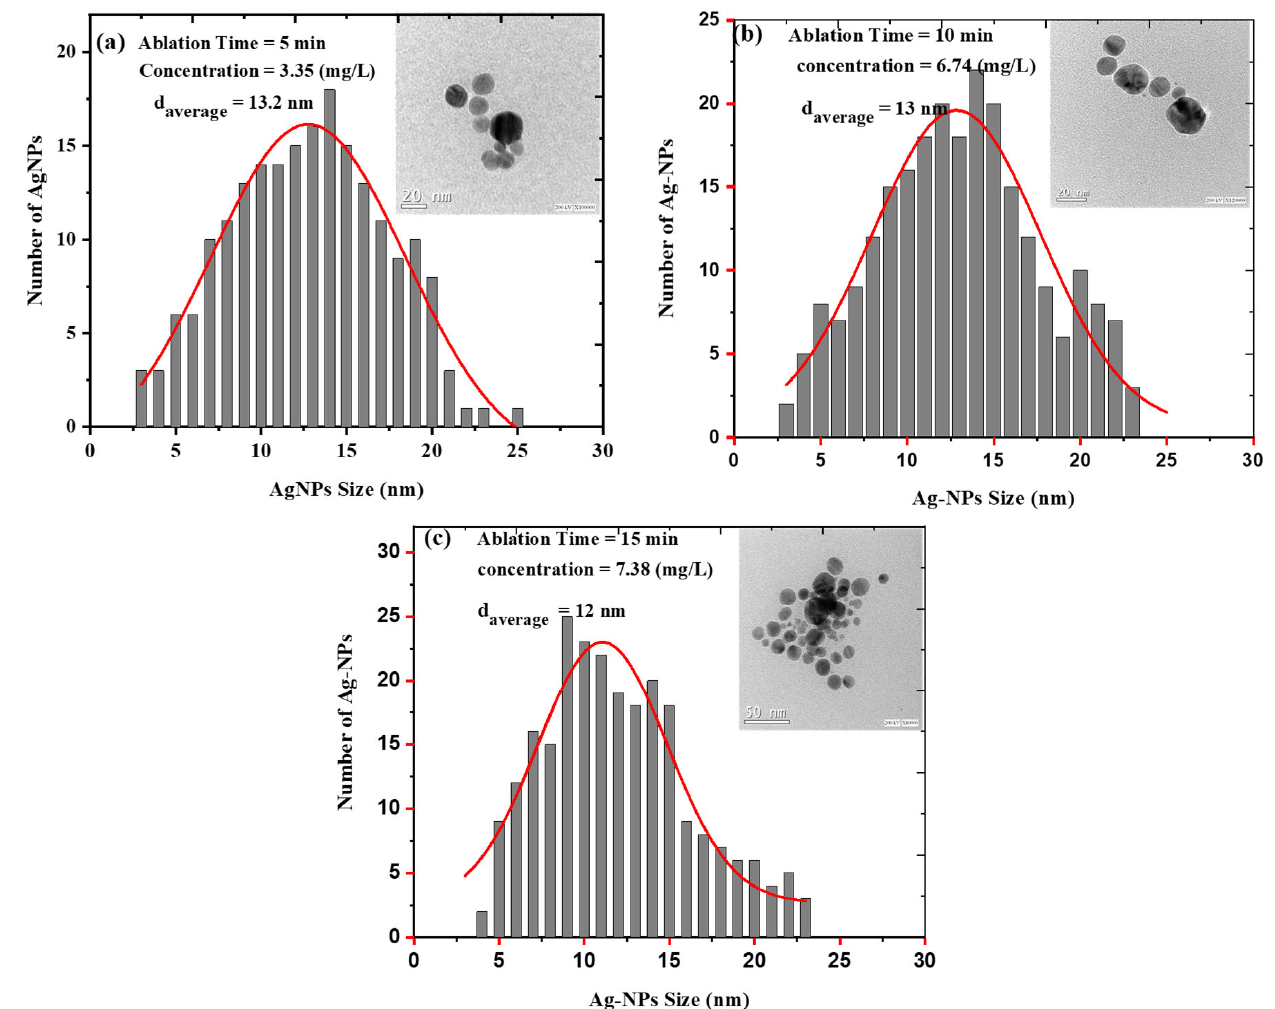
Figure 4. Size distribution of AgNPs synthesized at various ablation times. Insets show TEM images of AgNPs. ( a ) 5 min laser ablation time ( b ) 10 min laser ablation time ( c ) 15 min laser ablation time.